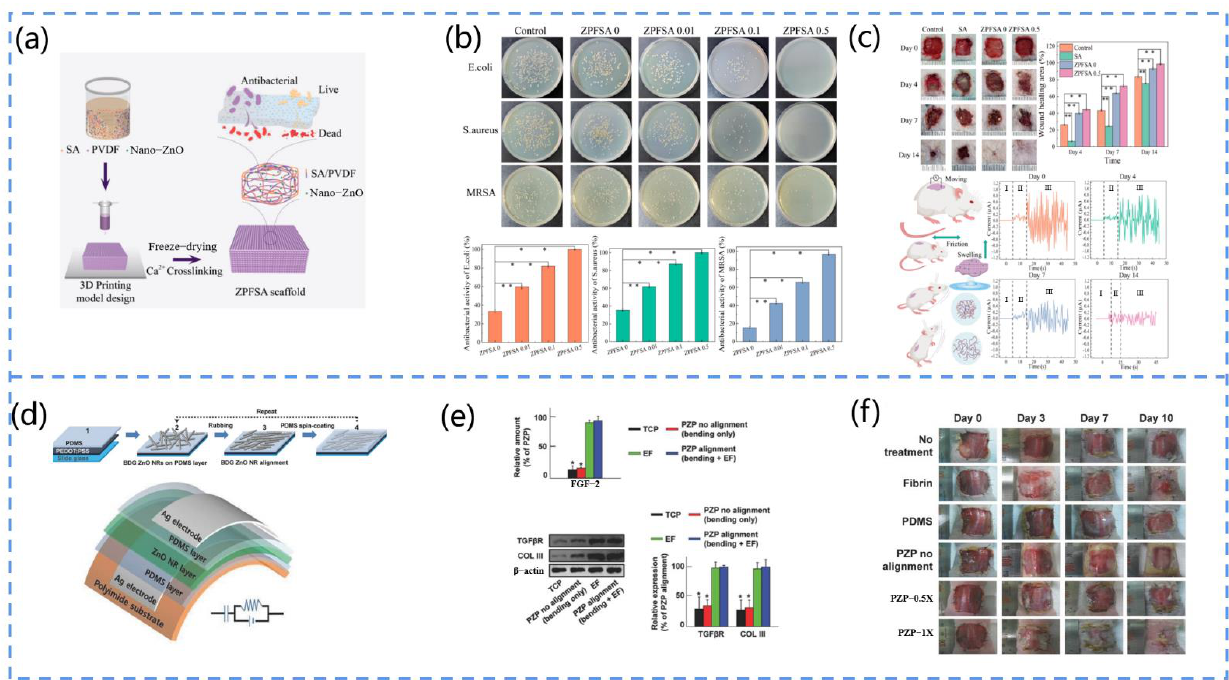
Figure 13. ( a ) Schematic diagram of the fabrication and composition of the ZPFSA piezoelectric scaf- fold. ( b ) Diagram of the test of the resistance of the device to different bacteria, subplots are images of scaffolds with E. coli, S. aureus, and MRSA and their antimicrobial properties, respectively. ( c ) Diagram of the relationship between the time and area of trauma healing and body surface current ( A is an ammeter; Ⅰ is baseline; Ⅱ is current on the normal skin; Ⅲ is current on the wound). Re- printed with permission from [148]. Copyright 2022, ACS Publications. ( d ) Illustration of the man- ufacturing process and structure of PZP (1, 2, 3, 4 represent the four steps of BDG ZnO NR-based PZP preparation). ( e ) Diagram of the gene expression of PZP-promoted cell growth factor. ( f ) Dia- gram of the process of PZP in promoting wound healing (PZP-0.5X denotes nine-layer PZP with a filling density of 54.8%, PZP-1X denotes nine-layer PZP with a filling density of 95.2%) [149]. Cop- yright 2017, Wiley Online Library. Table 1. Summary of recent PENG-based non-invasive sensing systems for the collection of medical information. Ref. Detection Range Selectivity Sensing Performance a